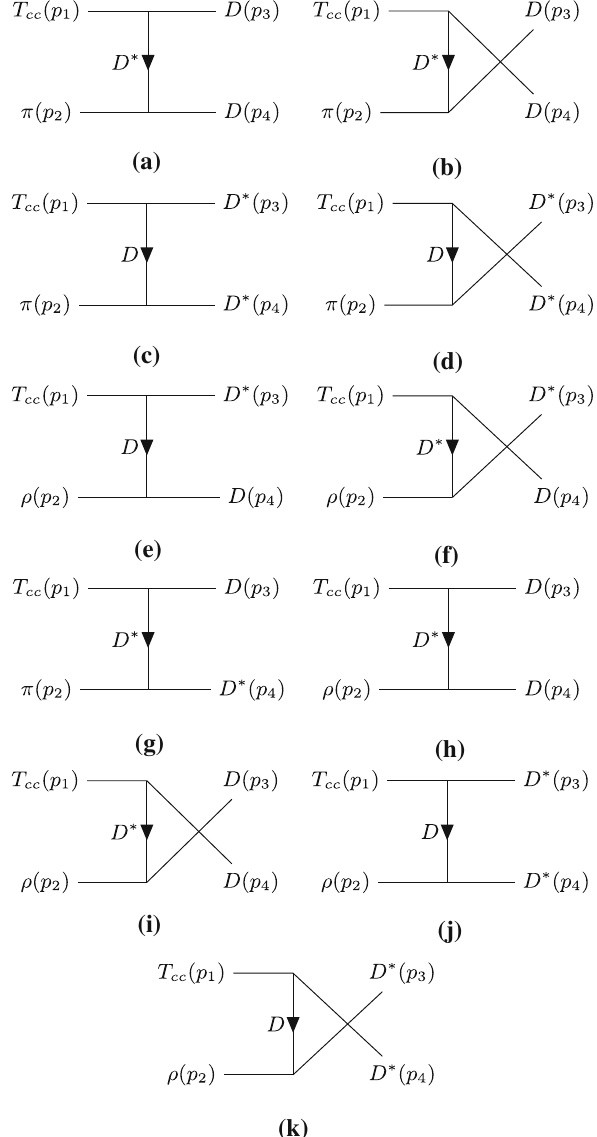
Fig. 1 Diagrams contributing to the following process (without spec- ification of the charges of the particles): T cc π → DD ( a and b ), T cc π → D ∗ D ∗ ( c and d ), T cc ρ → D ∗ D ( e and f ), T cc π → DD ∗ ( g ), T cc ρ → DD ( h and i ) and T cc ρ → D ∗ D ∗ ( j and k ). The particle charges are not specified